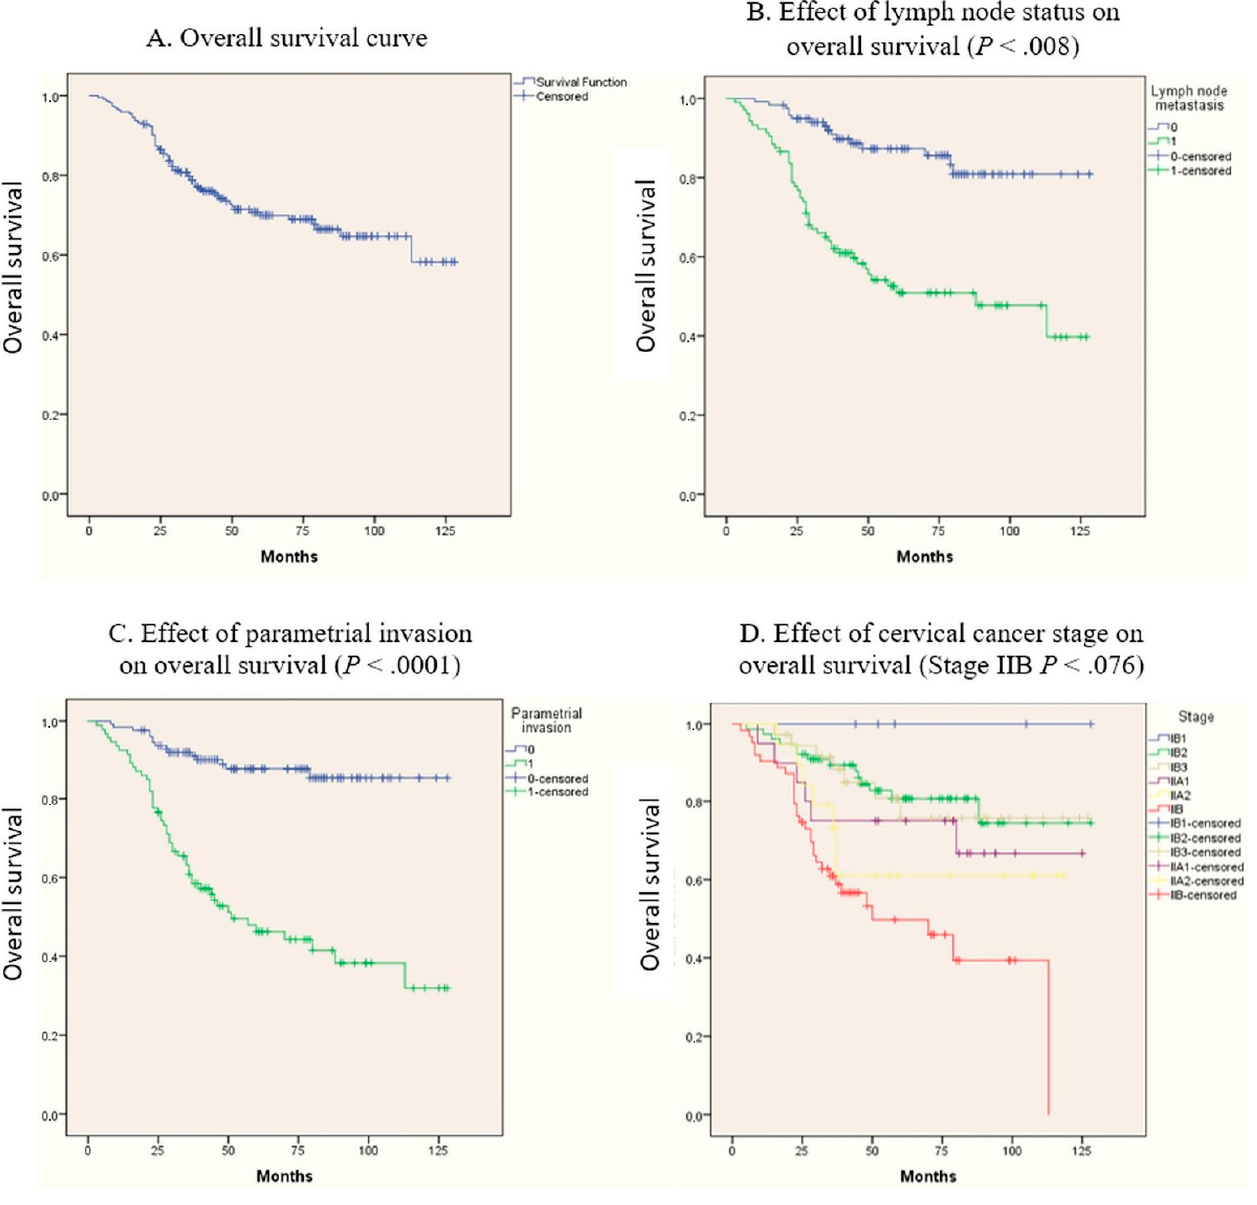
Figure 1. The most representative Kaplan–Meier curves.